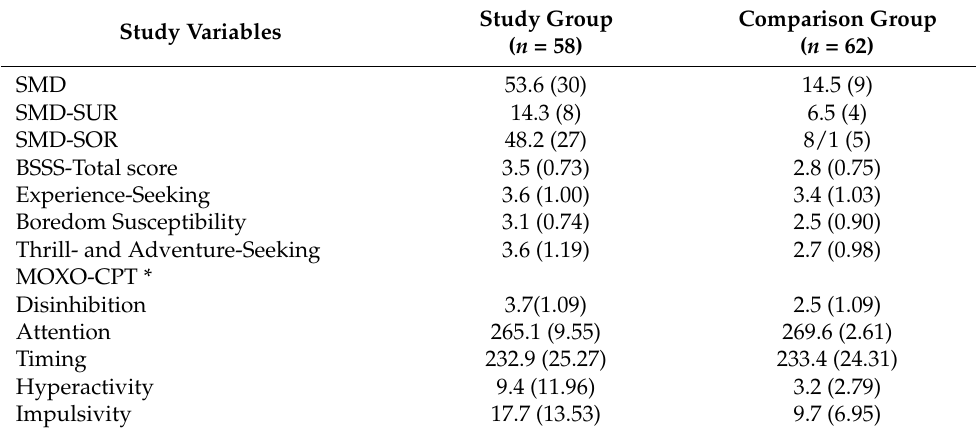
Table 2. Distribution of SMD (% ( n )), BSSS, and MOXO-CPT indexes (mean (SD)) in both